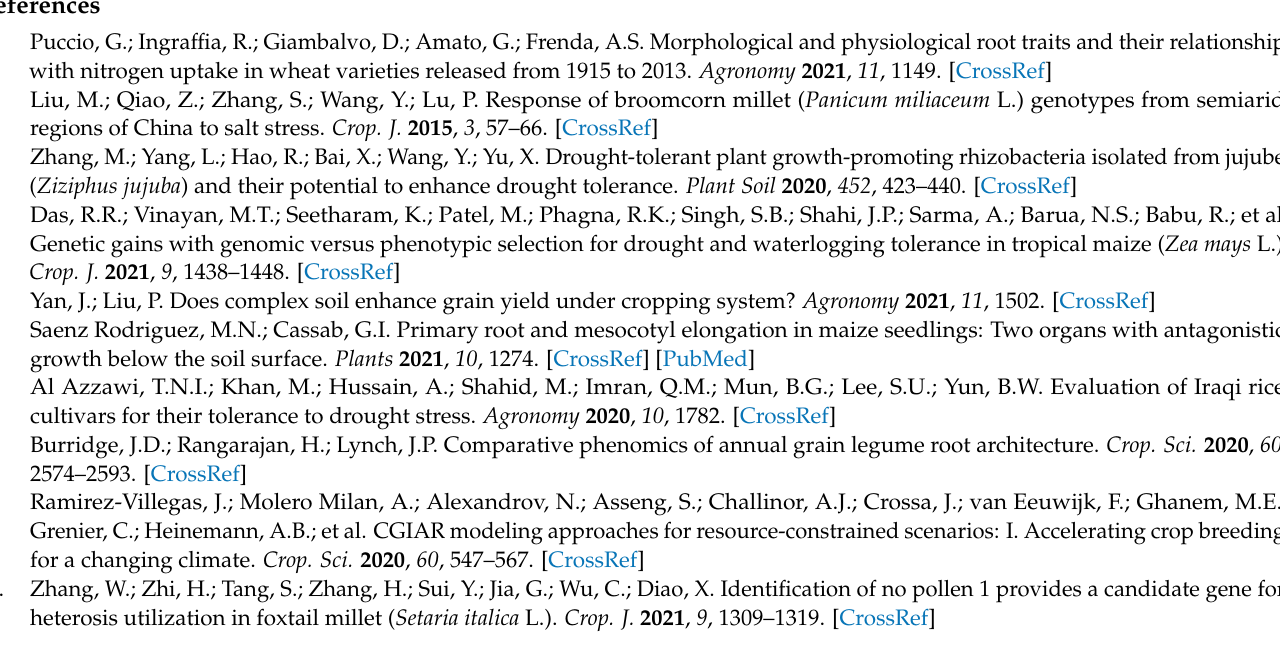
Figure S4: Linear fitting of root phenotypes, Figure S5: Comprehensive values of 18 selected traits, Figure S6: Dendrogram of agglomerative hierarchical clustering (AHC) of 18 selected root traits, Table S1: Cultivar, origin, seed provider, ecological region of 65 millet genotypes, Table S2: Pearson’s correlation matrix for 18 selected traits of 65 millet